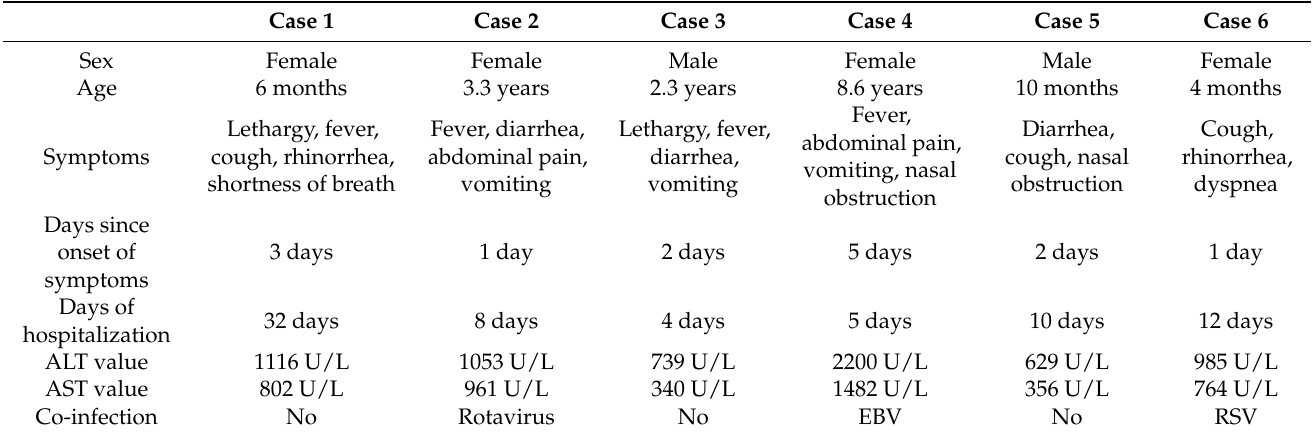
Table 6. Characteristics of cases with transaminase values above 500